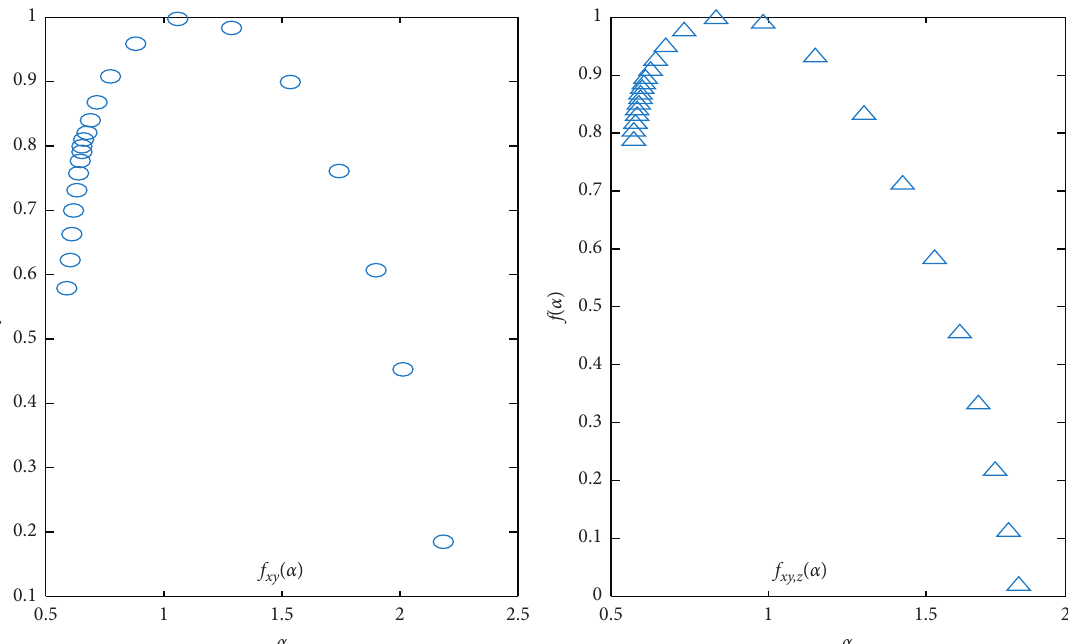
( α ) of bivariate time series obtained through MFDXA method and f xy